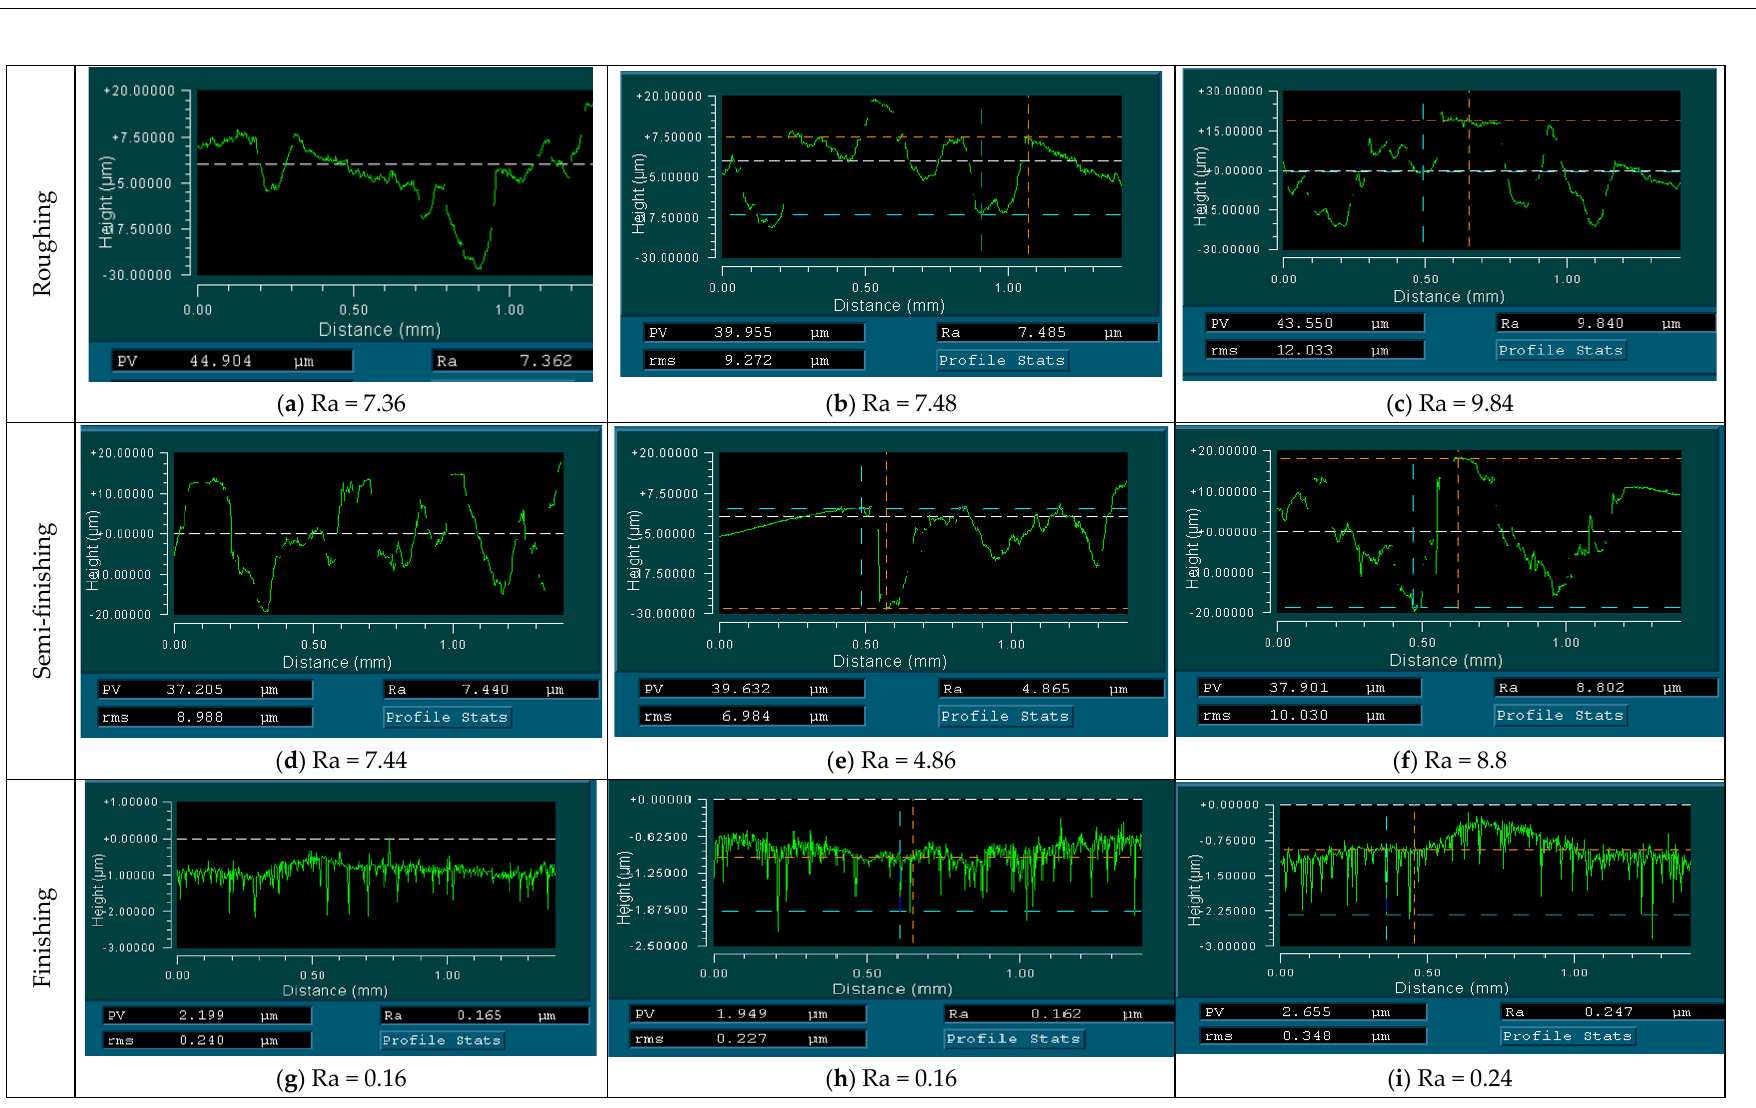
Figure 5. Profilograms of test specimen surfaces (1.4 × 1.5 mm).